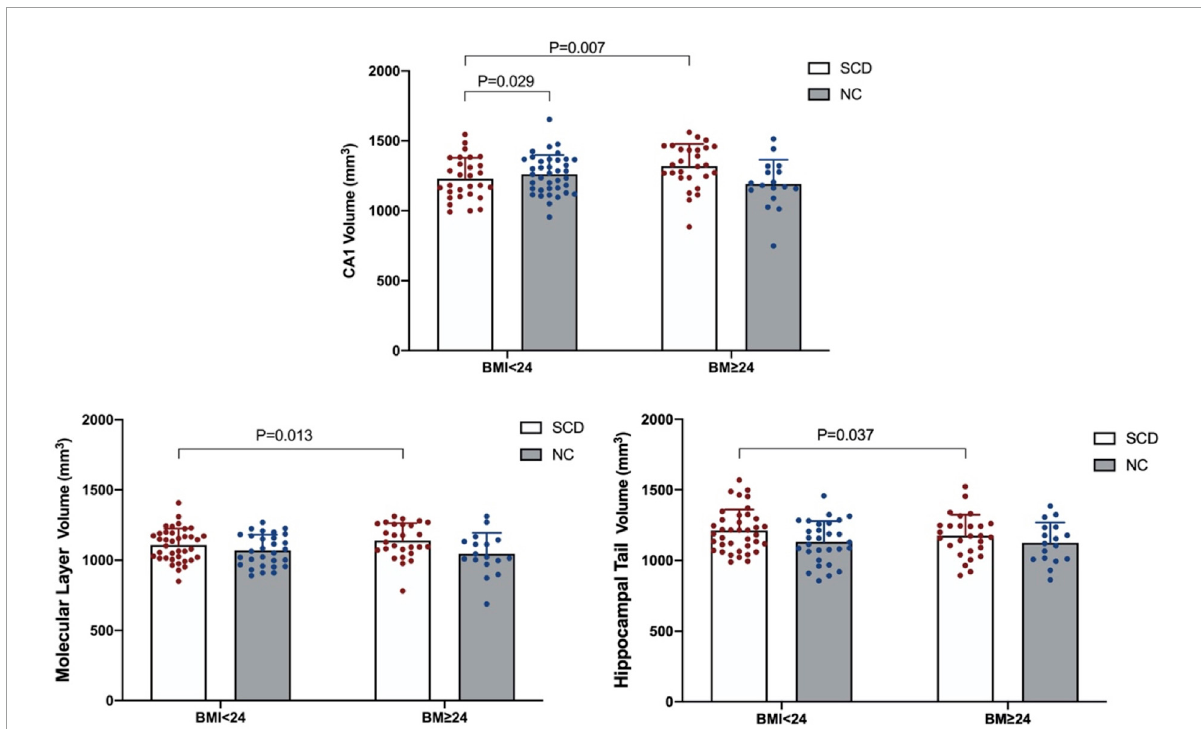
FIGURE1 Significant population × BMI interaction effect on gray matter volume in the hippocampal